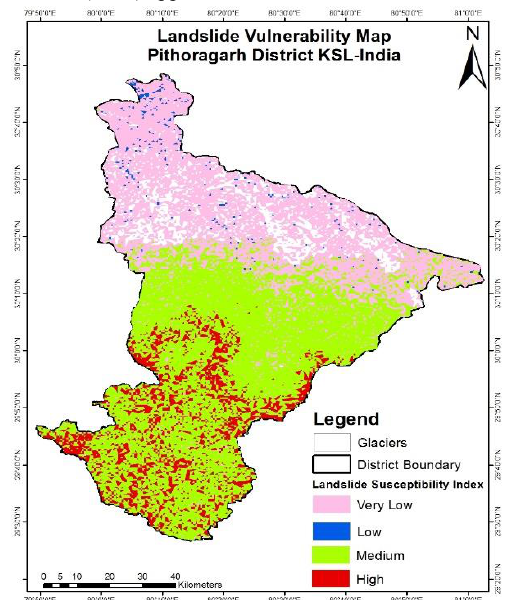
Fig 4: Landslide Prone Areas in Indian part of KSL